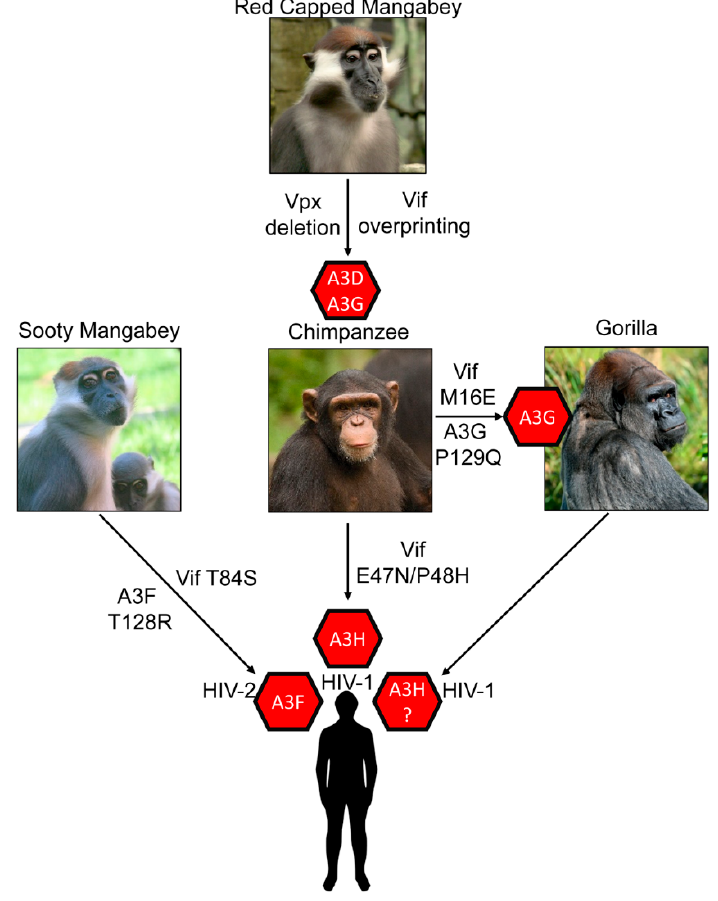
Figure 3. Overview of transmission barriers and associated mutations. The SIV cpz is most similar to a SIV rcm –like virus (Red Capped Mangabey), although the vpu and env genes are more similar to SIV from Cercopithecus monkeys. This recombination within chimpanzees created SIV cpz that had a deletion of vpx and generated a unique vif that overlaps with vpr at its 3’ end and contains additional amino acids by a process called overprinting. This new Vif protein could counteract chimpanzee A3D and A3G and facilitated the cross-species transmission. Once in the chimpanzee, the SIV was more easily transmissible to humans and gorilla. Gorilla A3G is resistant to SIV cpz Vif due to a P129Q change from chimpanzee to gorilla A3G. This necessitated a corresponding change in SIV cpz Vif (M16E) to antagonize gorilla A3G and cross the species barrier. The gorilla A3G is polymorphic at amino acid 129 (P/Q) suggesting that this could render certain gorillas more susceptible to transmission of SIV cpz allowing the virus to gain foothold. It is also possible that spread of SIV gor selected for an increased frequency of the A3G 129Q change in gorillas. The SIV